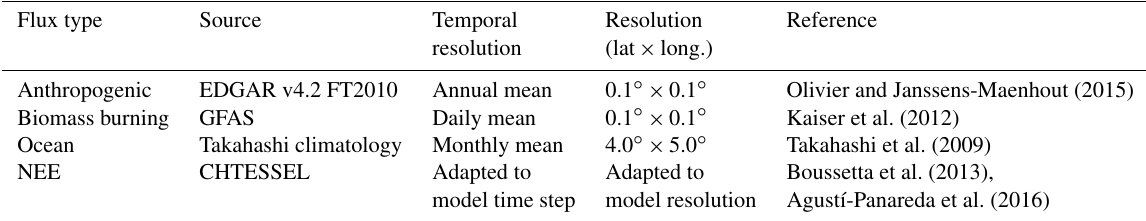
Table 1. Datasets and models of CO 2 fluxes used in simulations listed in Table 2.